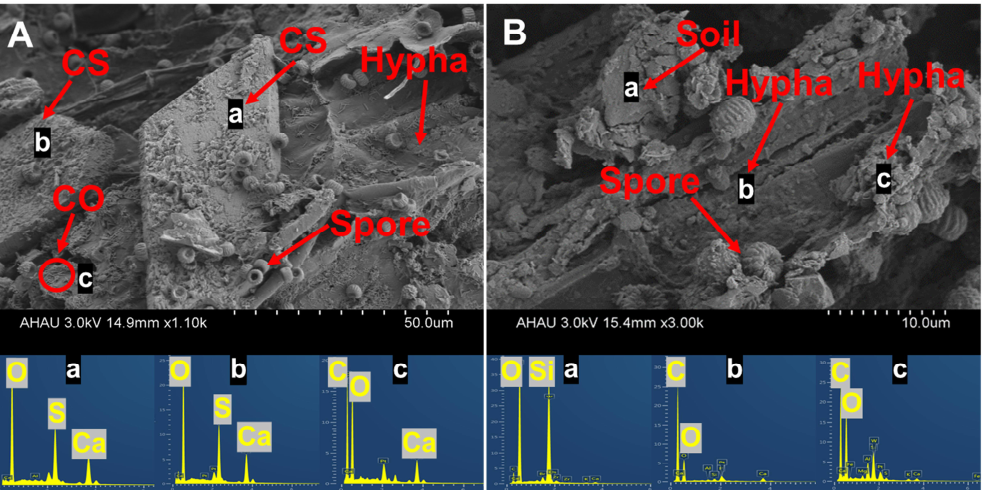
Figure 7. SEM-EDS imaging of the PGF ( A ) and SS + PGF ( B ) after 4 weeks of incubation. Points a, b, and c represent EDS analysis in PGF ( A ) and SS + PGF ( B ) treatments. CO, calcium oxalate (CaC 2 O 4 ); CS, calcium sulfate (CaSO 4 ).